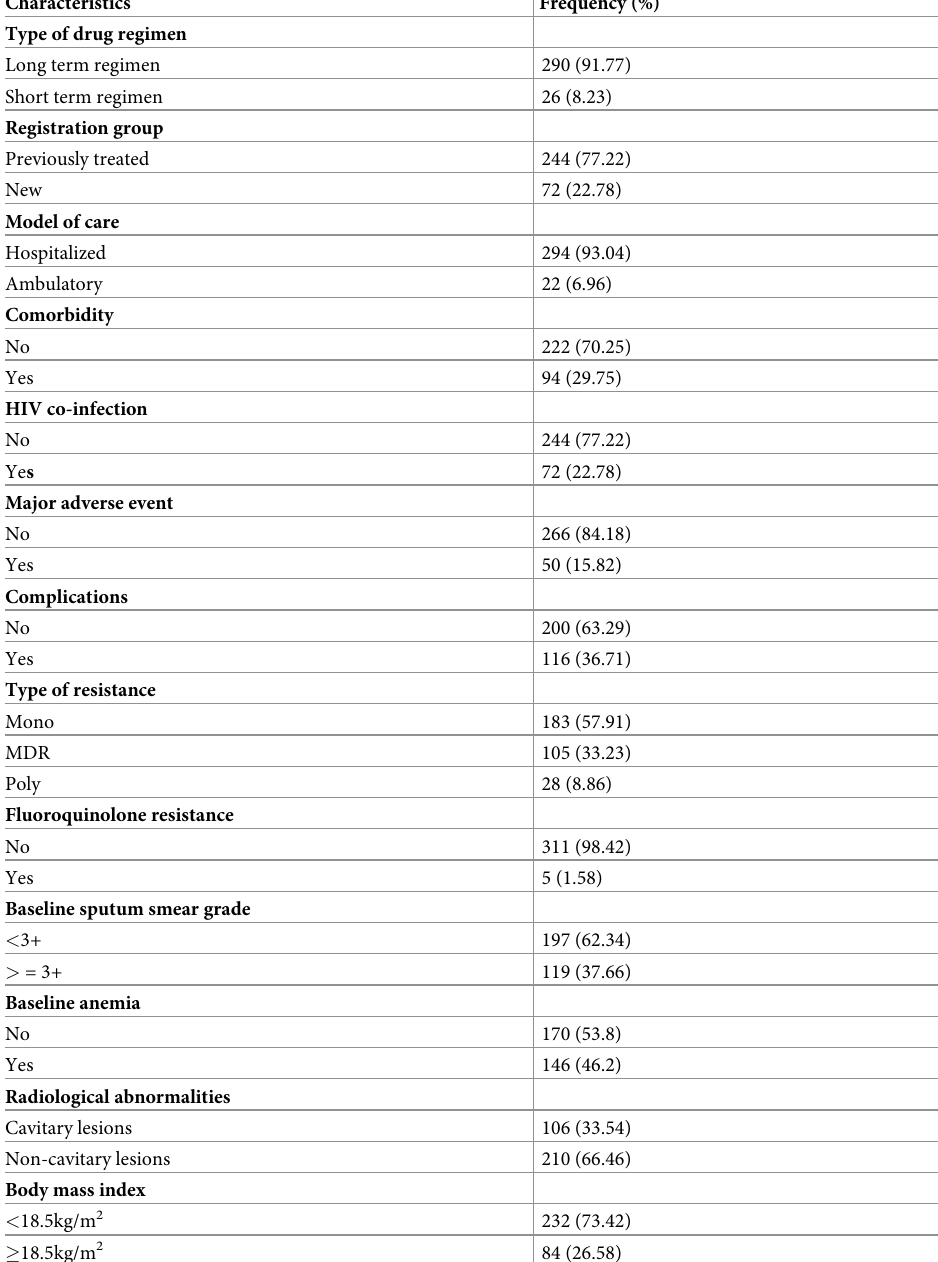
Table 2. Clinical characteristics of MDR TB patients in Northwest Ethiopia, 2010 to 2020 (N =